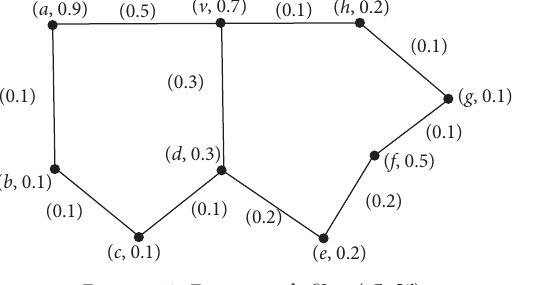
Figure 18: Fuzzy graph G � ( J , K )